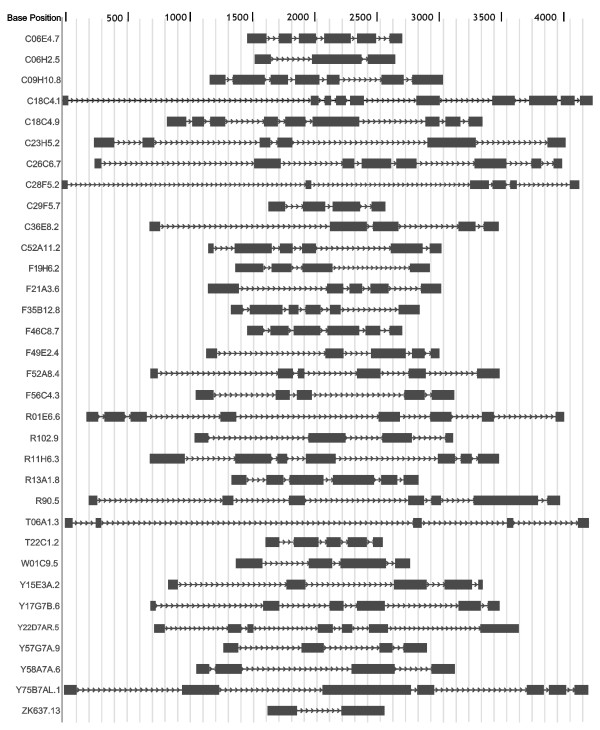
Genomic structures.